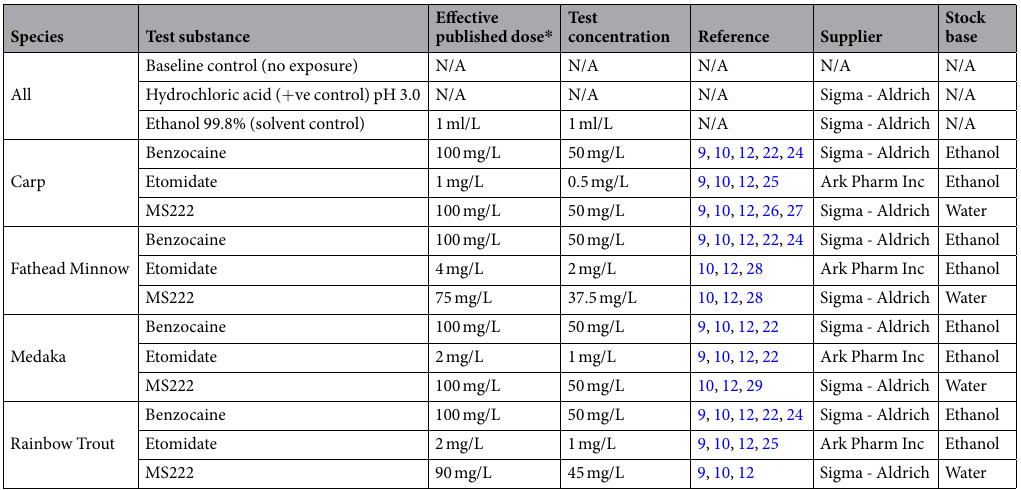
Table 2. Test substance effective dosage and supplier details. * Effective dose = Dose at which Stage 5 anaesthesia is achieved. Where the referenced articles cite multiple alternative concentrations, the median was chosen. AstraZeneca do not endorse or recommend any companies listed, other suppliers were